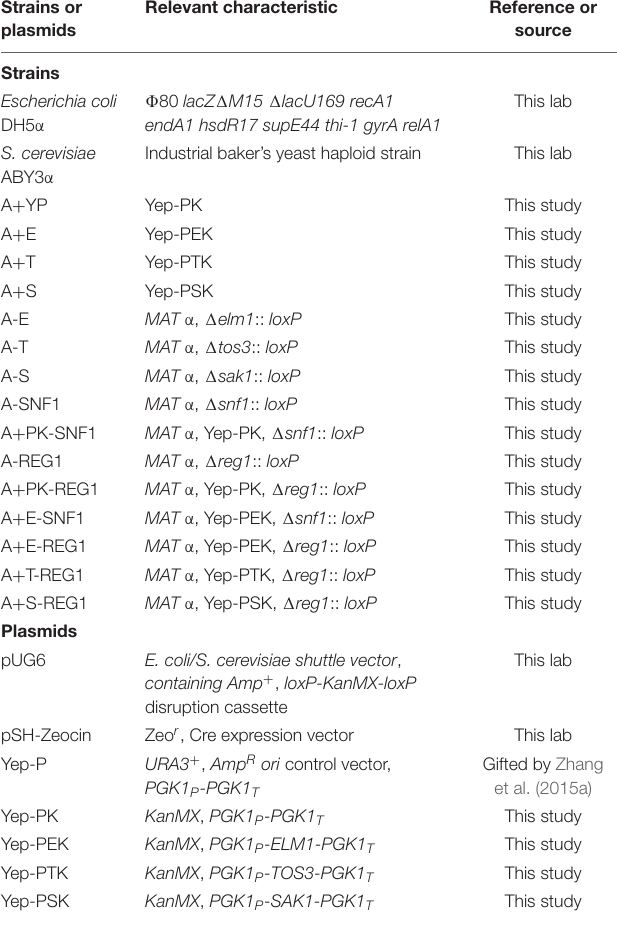
TABLE 1 | Characteristics of strains and plasmids used in the current